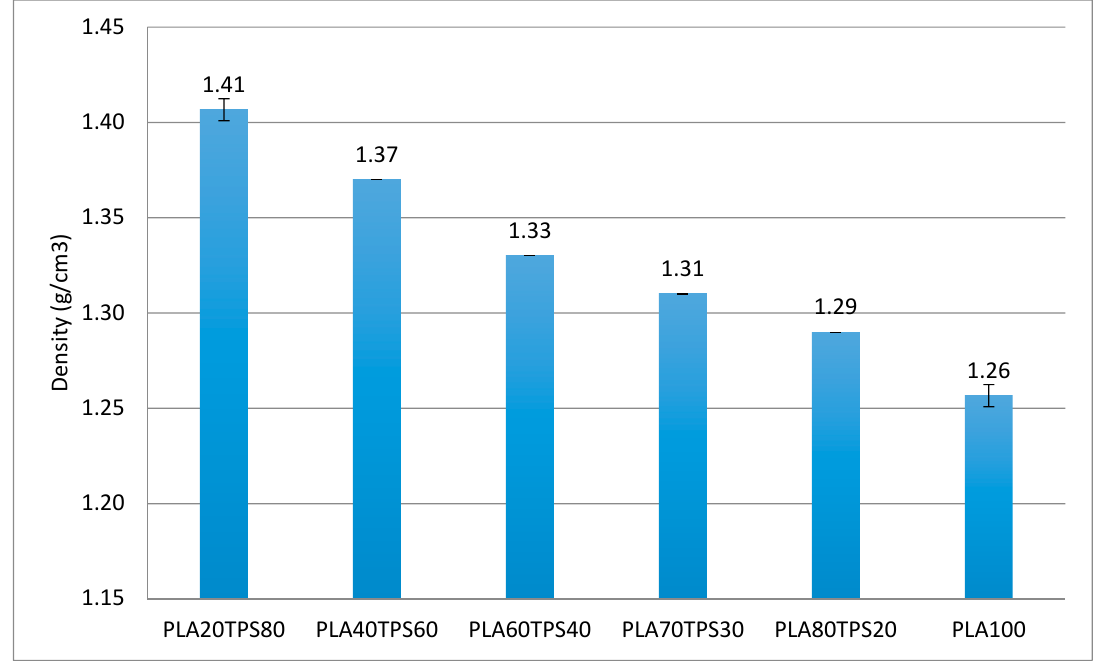
Figure 4. Density of PLA100 and PLA/TPS blend bionanocomposites.